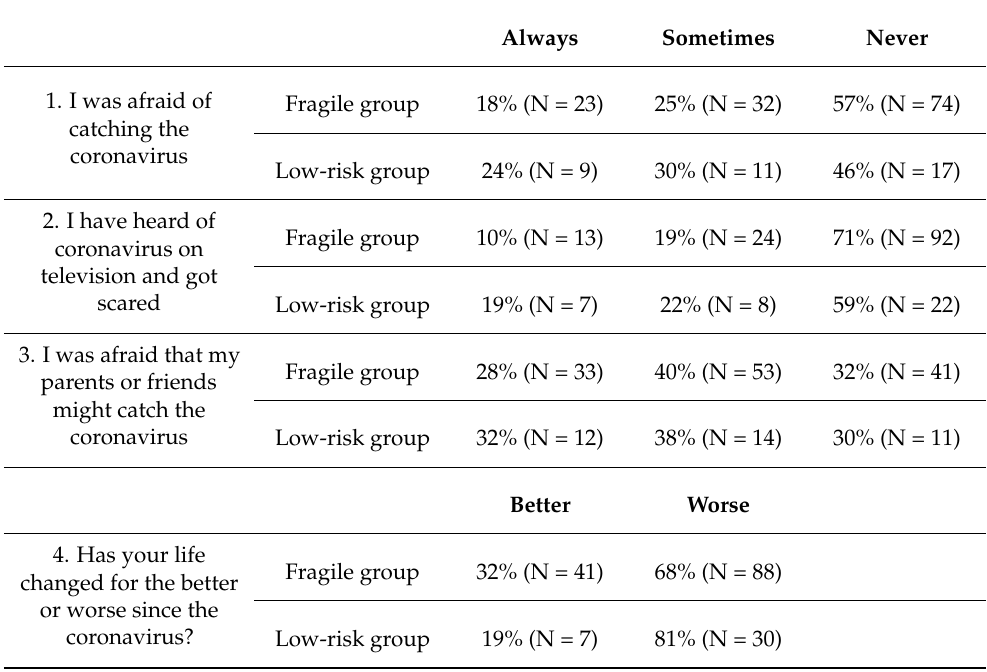
Table 5. Emotional experience and feelings towards pandemic between the fragile group and the low-risk